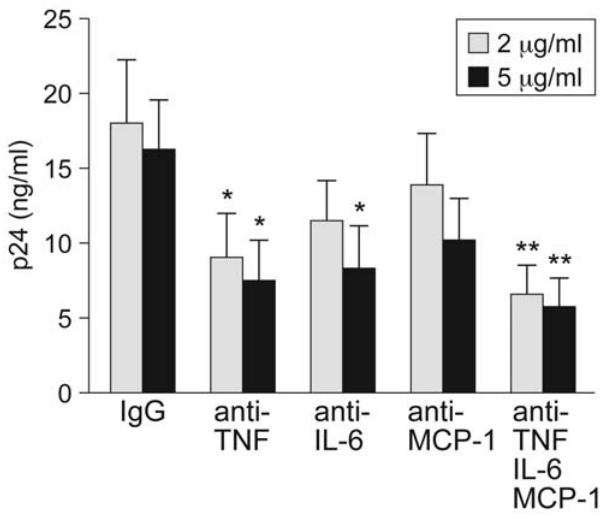
Figure 3. Blocking TNF or IL-6 decreases HIV-1 replication significantly in a dose dependent manner. Virus replication was determined by measuring HIV-1 p24 levels in the culture supernatants in PBMC from six individual donors at day 7 post-infection performed in duplicate. Blocking TNF (at 2 ug/ml or 5 ug/ml) or IL-6 (5 ug/ml) significantly decreased virus replication (*, p , 0.05) as compared to the same concentrations of an IgG 1 control antibody. Blocking of MCP-1 alone on average minimally decreased HIV-1 replication, but this did not reach statistical significance. Virus replication was further signifi- cantly inhibited in cultures containing a mixture of blocking antibodies to TNF, IL-6, and MCP-1 at a concentration of 2 m g/ml and 5 m g/ml (**, p , 0.01). Results are shown as mean 6 SEM. were non-significantly higher in cells infected with HN878 pks1- 15::hyg compared with cells infected with HN878 (Figure 4A).